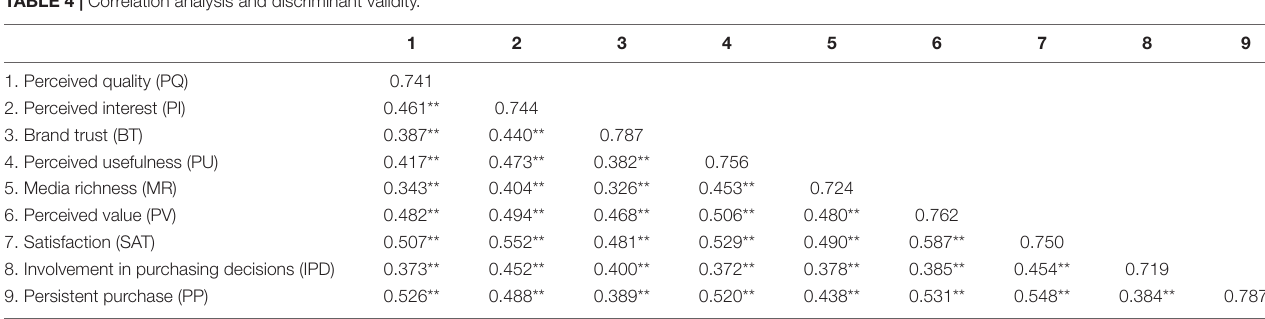
TABLE 4 | Correlation analysis and discriminant